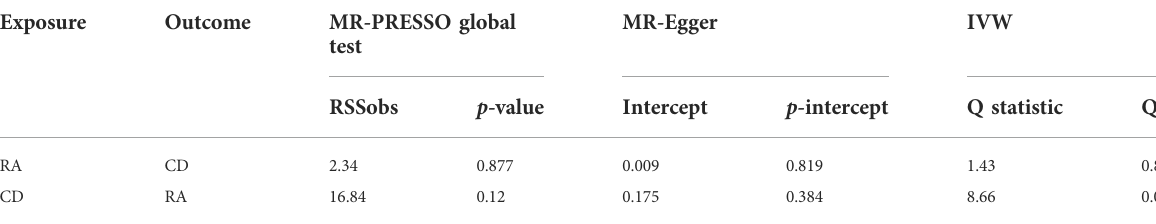
TABLE 1 Heterogeneity and horizontal pleiotropy analyses between RA and CD.